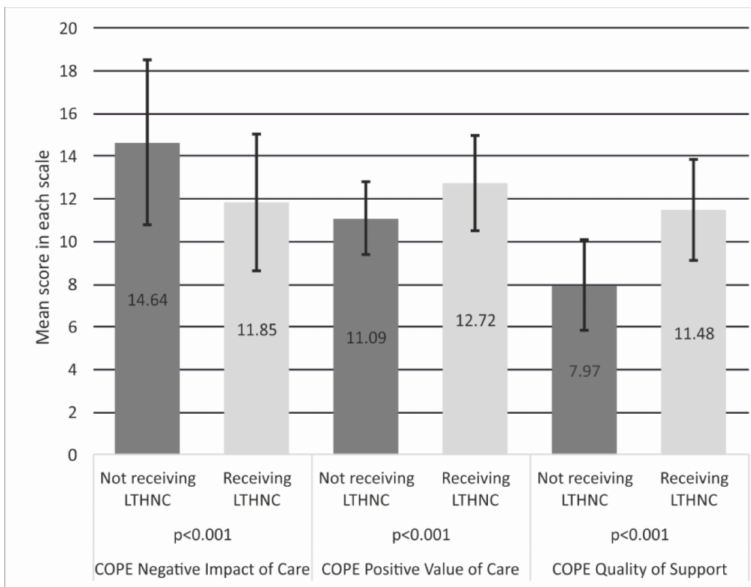
Figure 1. Mean evaluation of the Negative Impact of Care (NIoC), Positive Value of Care (PVoC) and the Quality of Support (QoS) depending on the presence of LTHNC (Carers of Older People in Europe (COPE) NIoC: Lower scores are better; COPE PVoC and COPE QoS: Higher scores are better).